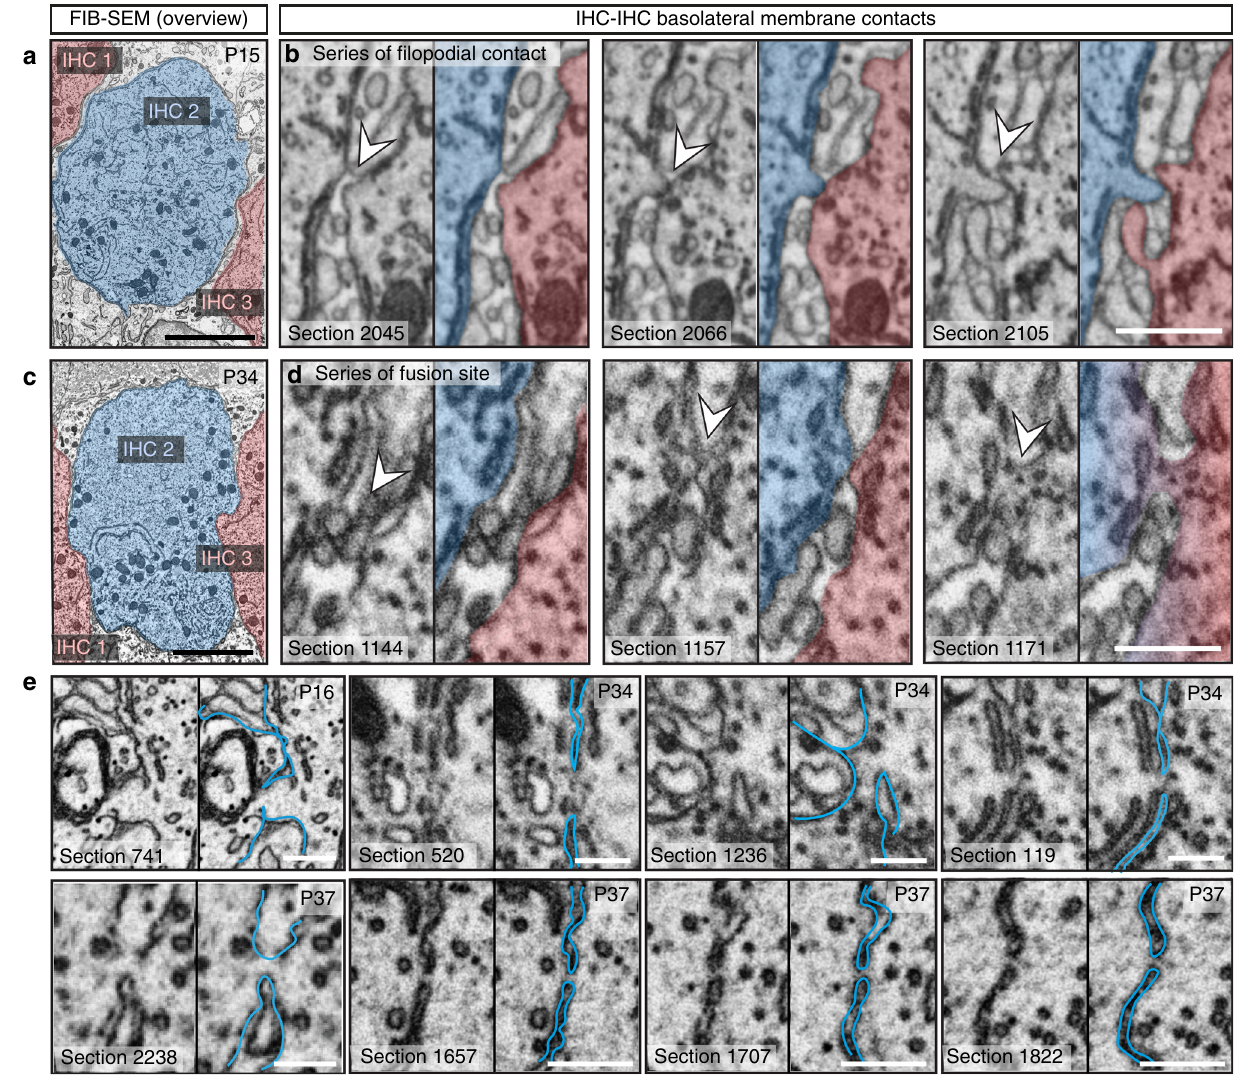
Fig. 5 3D electron microscopy indicates IHC – IHC fusion as a putative basis for IHC coupling. a – e FIB-SEM datasets of basolateral membrane contacts between IHCs. a P15 IHCs are tightly wrapped around by SCs and are separated by a distance ranging from 100 to 648 nm ( fi rst section below the nucleus). c P34 IHCs share prominent fl at membrane contacts (blue – red contacts). For each FIB-run we numbered the IHCs, whereby IHC 2 is the full IHC in the centre of the region of interest (highlighted in blue), making contacts to the neighboring IHCs (shown in red). b – e Representative micrographs of IHC – IHC contacts. P15 IHCs frequently show fi lopodia reaching neighboring IHCs ( b ). d At P34, some fl at membrane contacts appear to include fusion sites with membrane continuity and cytoplasmic bridge (white arrowheads). e Depicted are the observed putative IHC fusion sites in the P16 and the